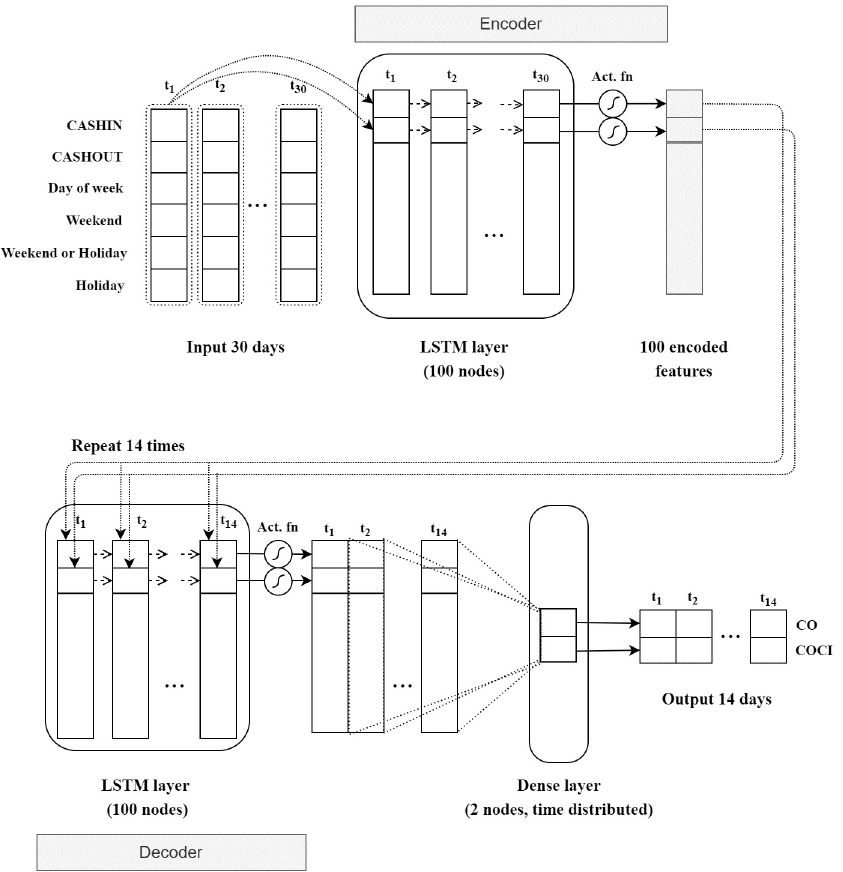
Fig 6. Cash stock prediction model structure based on LSTM